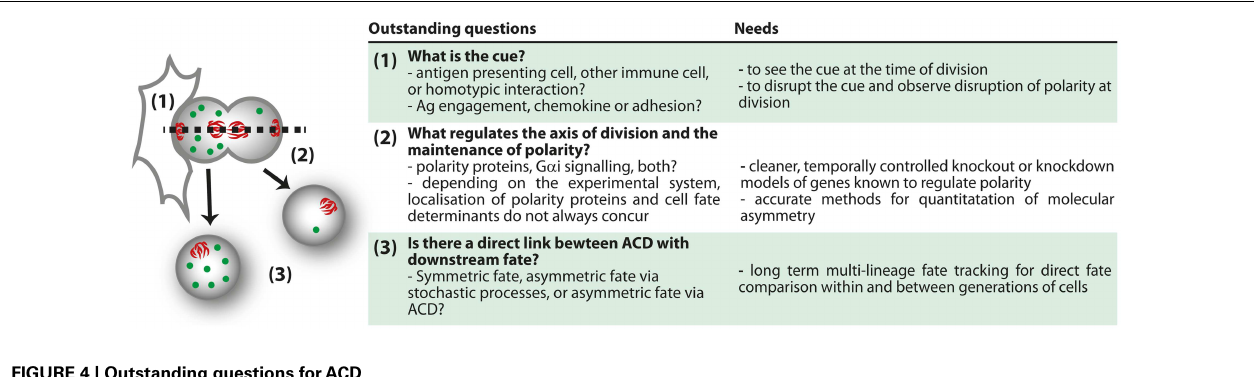
FIGURE 4 | Outstanding questions forACD